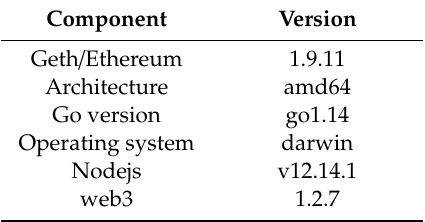
Table A1. Configuration settings of Ethereum and other